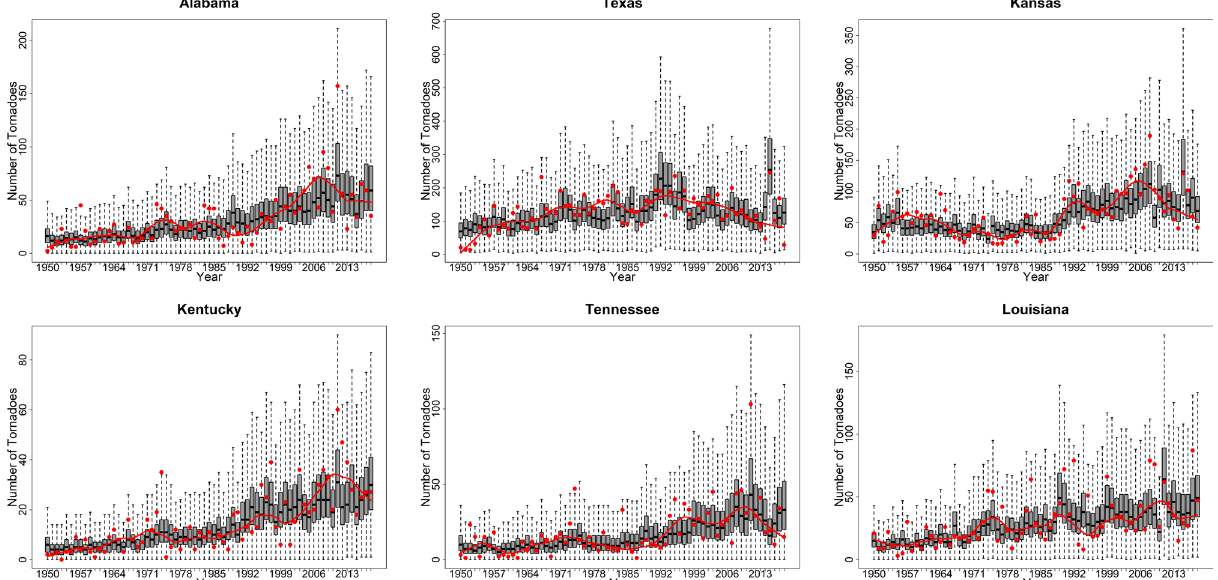
Figure 4. Boxplot of posterior distribution of tornado counts in Alabama, Texas, Kansas, Kentucky, Tennessee and Louisiana. The median of posterior distribution in a state can be referred to the estimated annual tornado counts in that state. The red circles and red line represent annual records of observed tornado counts along with an 11-year low-pass filter to visualize observed trend.